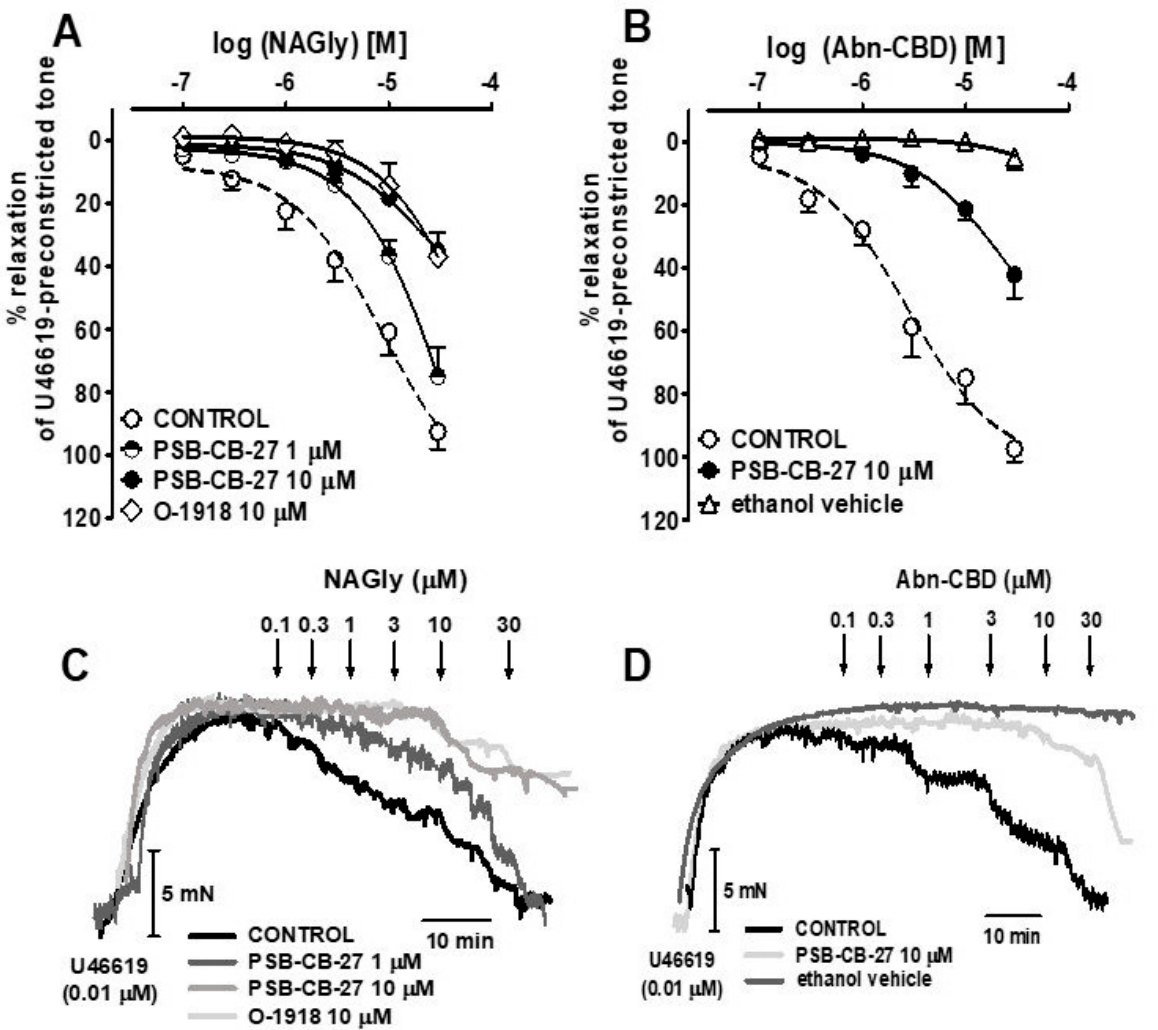
Figure 3. Influence of PSB–CB–27 ( A – D ) and O–1918 ( A , C ) on the vasorelaxation induced by NAGly ( A , C ) and Abn–CBD ( B , D ) in endothelium-intact isolated human pulmonary arteries.